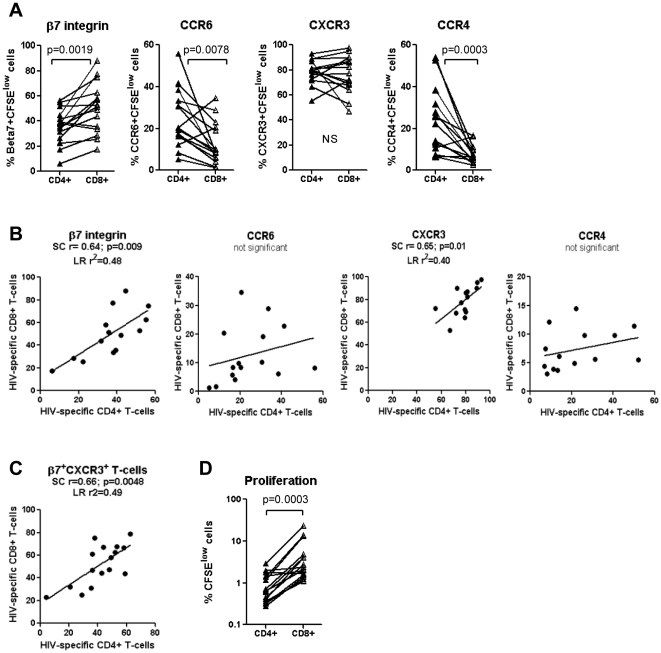
Potential colocalisation of HIV-specific CD8+ and CD4+ T-cells via integrin β7 but not CCR6.(A–C) PBMC from five SP subjects were stimulated with different HIV peptide pools or recombinant HIV-p24 and analyzed by polychromatic flow cytometry for the expression of homing molecules, as described in Figures 2 and 3. HIV-specific CD4+ and CD8+ T-cells were analyzed for (A–C) the expression of the homing molecules β7 integrin, CCR6, CXCR3, and CCR4 (D) the proliferation potential. (A) Shown is the expression of homing molecules on matched CD4+
versus CD8+ T-cells specific for different HIV peptide pools in five different SP subjects. Shown are correlations between (B) the frequency of matched HIV-specific CD4+ and CD8+ T-cells expressing β7 integrin, CCR6, CXCR3, or CCR4 alone, and (C) co-expressing the β7 integrin and CXCR3 molecules (β7+CXCR3+ phenotype). (D) Shown is the percentage of matched CD4+
versus CD8+ T-cells proliferating (CFSElow) in response to different HIV peptide pools. Paired T-test p-values are indicated in the Figures A and D. Spearman correlation r and p-values and linear regression r2 values are indicated in the Figures B and C.